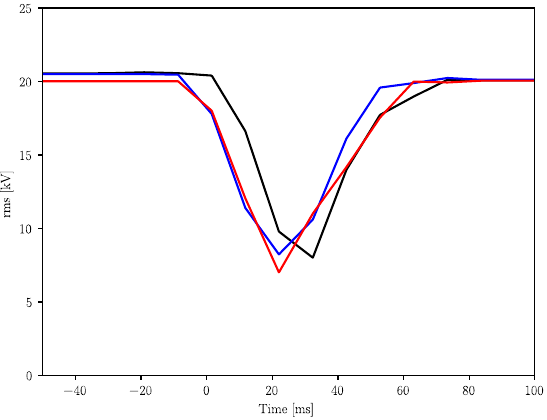
Figure 3. False event due to VTs saturation: rms voltage values.